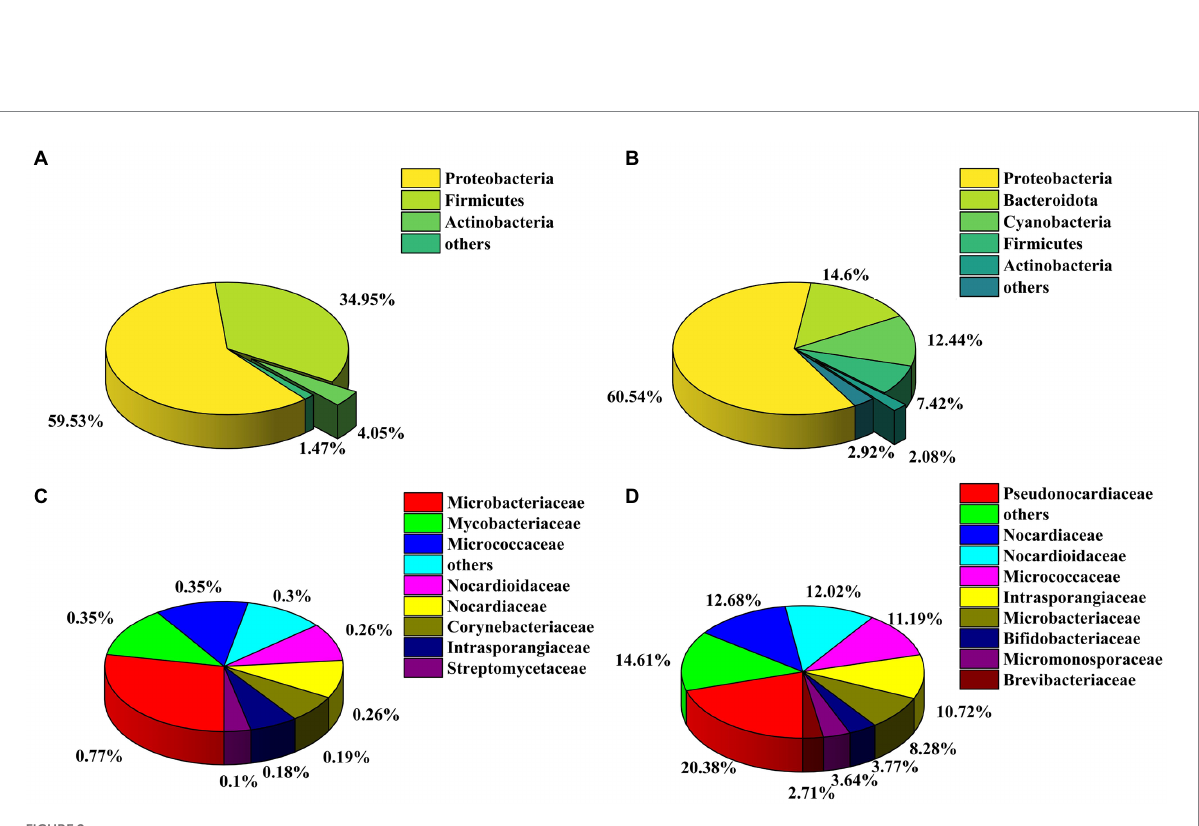
FIGURE 2 Analysis of culture-independent bacterial communities. Relative abundance of OTUs at the phylum level of honeybee gut (A) and honeycomb (B) ; Relative abundance of OTUs at the family level from the phylum Actinobacteria of honeybee gut (C) and honeycomb (D)